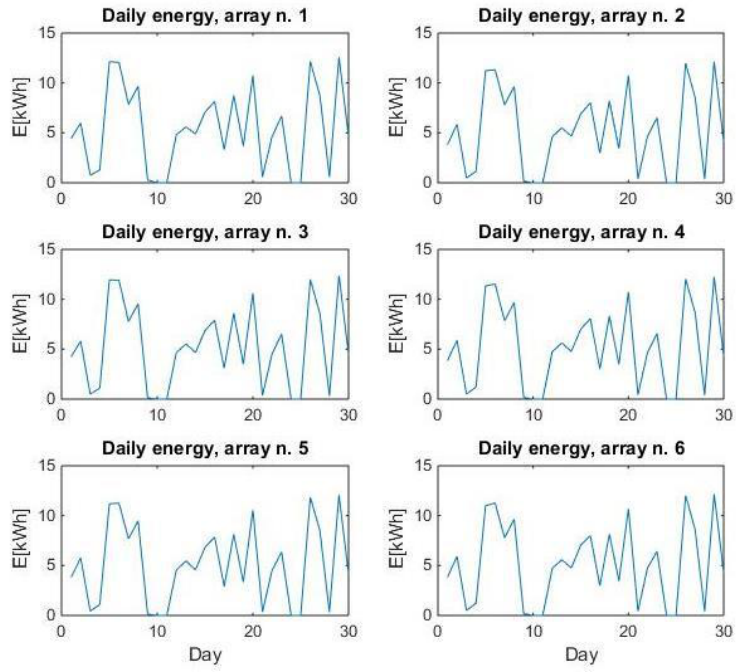
Figure 3. Energy, in kWh, produced by each array during one-month. Table 1. Mean, median and variance of the daily energy (in kWh) produced by each array and relative spreads for one month. Skewness, kurtosis, and p -value.